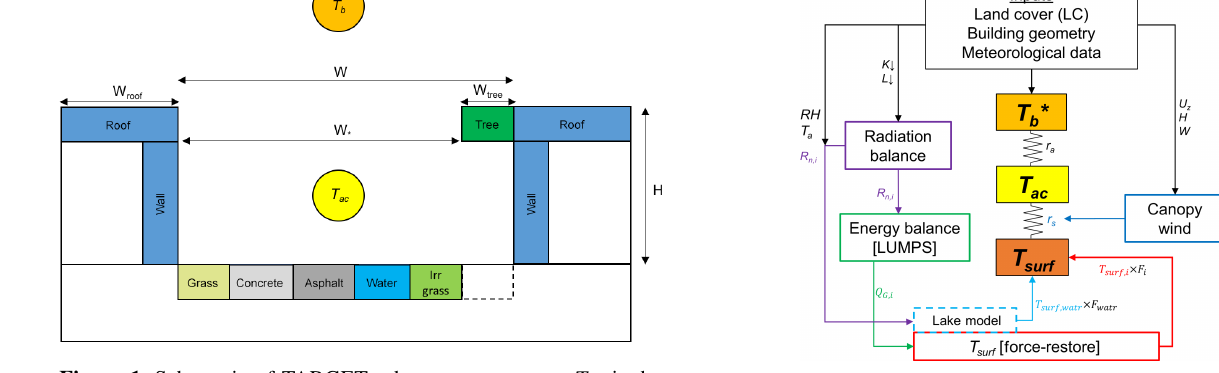
Figure 2. Overview of approach used in TARGET. T ac is street- level (urban canopy layer) air temperature ( ◦ C), T b is the air tem- perature above the urban canopy layer ( ◦ C), T surf ,i is the surface temperature for surface type i , K ↓ is incoming shortwave radiation (Wm − 2 ), L ↓ is incoming longwave radiation (Wm − 2 ), T a is ref- erence air temperature ( ◦ C), R n is net radiation (Wm − 2 ), RH is rel- ative humidity (%), F i is the fraction of land cover type i (%), Q H,i is the sensible heat flux for surface i from LUMPS (Wm − 2 ), Q G,i is the storage heat flux for surface type i from LUMPS (Wm − 2 ), U z is the reference wind speed (ms − 1 ), H is the average building height (m), W is the average street width (m), r s is the resistance from the surface to the canopy (sm − 1 ), and r a is the resistance from urban canopy to the atmosphere (sm − 1 ). T ∗ is a homoge- b neous value for the whole domain, which is diagnosed through the processes laid out in Sect.